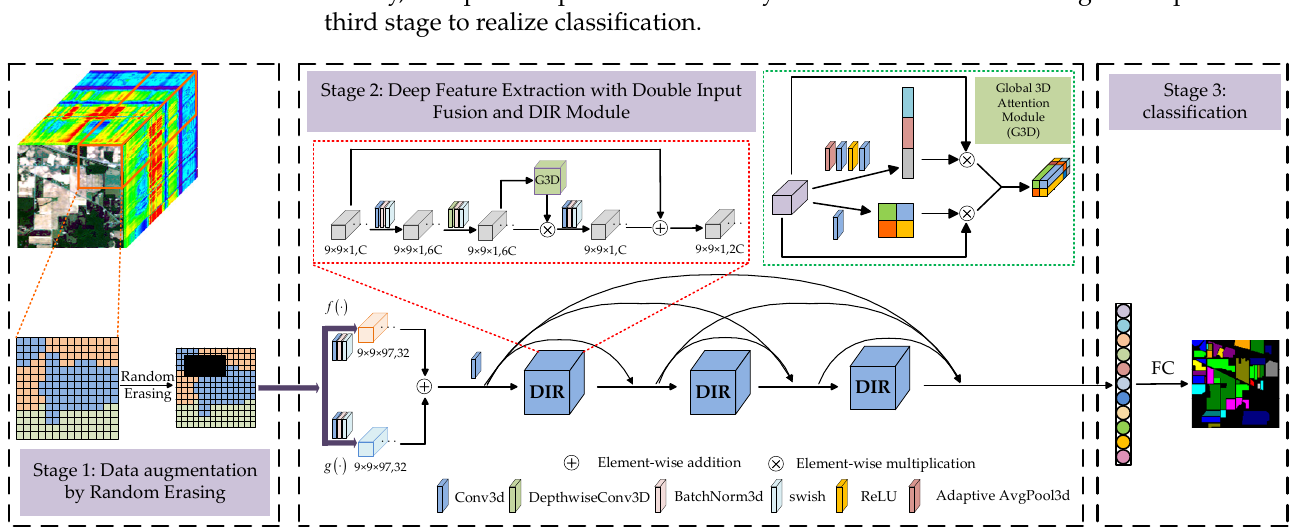
Figure 2. The structure of the proposed DSSIRNet.